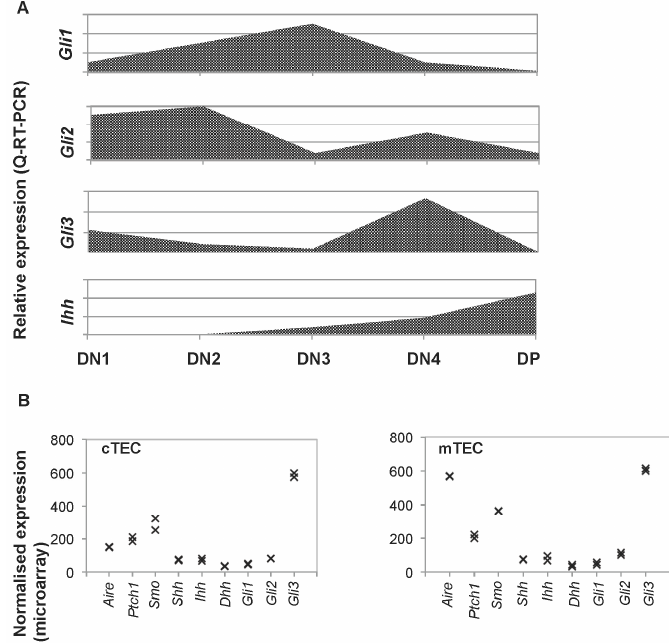
Figure 2. Expression of components of the Hh signalling pathway in embryonic thymocytes and TEC. ( A ) Graphs illustrate the relative expression of Gli1, Gli2, Gli3, and Ihh in sorted DN1, DN2, DN3, DN4, and DP thymocytes from E16.5 thymus, determined by quantitative reverse